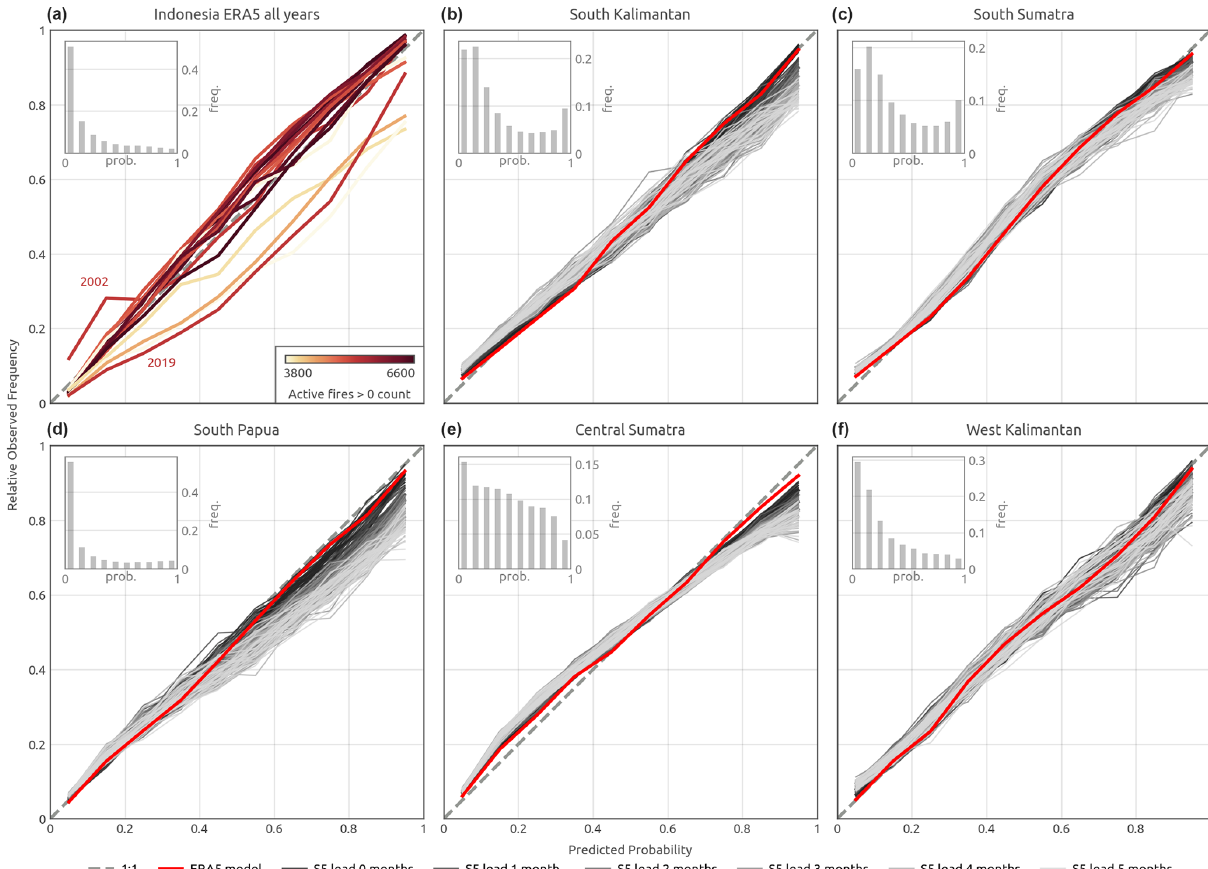
Figure 4. Reliability diagrams of occurrence probability predictions of active-fire counts of > 0 cases. Inset axes show ERA5-based prob- ability prediction frequency histograms. (a) ERA5-based prediction reliability curves for all of Indonesia for each year in the record. The colour of the lines corresponds to an active-fire count of > 0 cases for the year. (b–f) Mean reliability curves for the sub-regions (Fig. 1), showing ERA5- (red) and SEAS5-based ensemble mean prediction reliability curves at different lead times (shades of grey, bottom legend). Dotted lines indicate perfect reliability (1 : 1